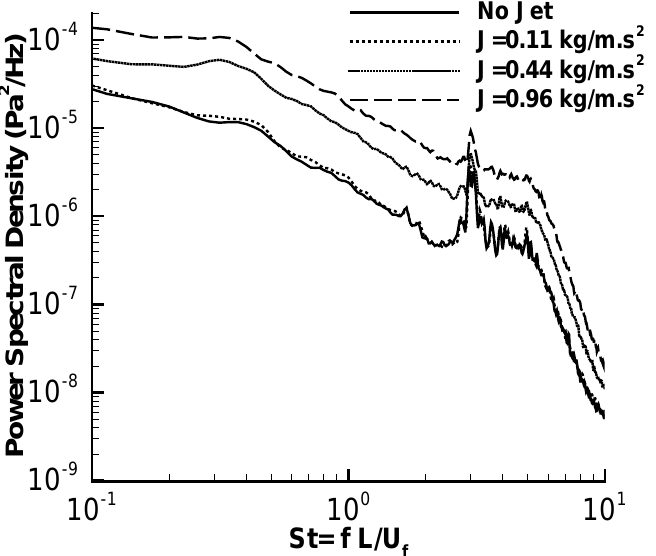
Figure 13. Unsteady wall pressure power spectral density at x / L = 0.5 for Re D ≈ 50,000; sharp edge at LE; different J